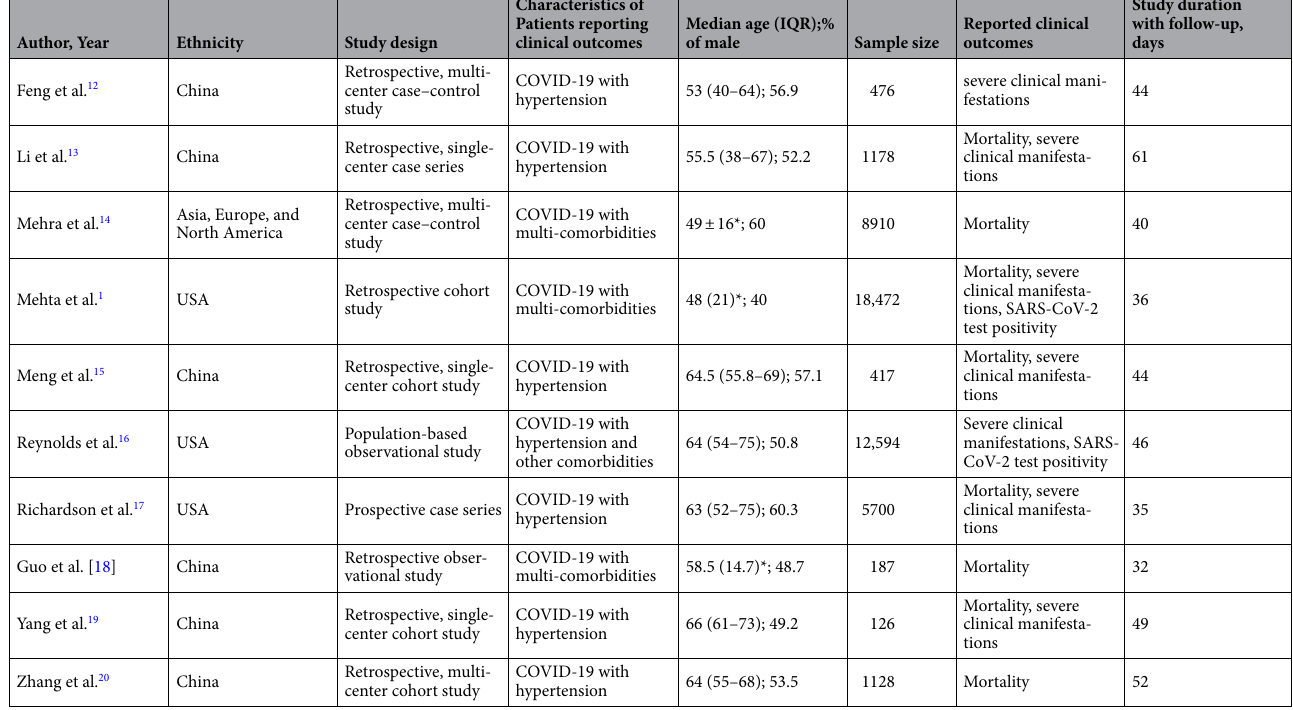
Table 1. Baseline characteristics of included studies. *Age reported as mean with standard deviation (SD); IQR = Interquartile range; COVID-19 = Corona virus disease-2019; SARS-CoV-2 = Severe acute respiratory syndrome corona